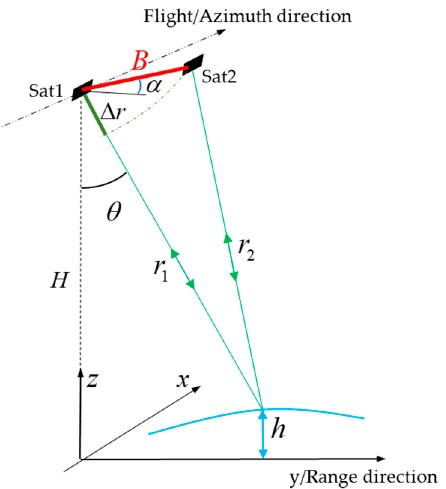
Figure 1. Schematic diagram of triangulation altimetry of Imaging Radar Altimeter (IRA).